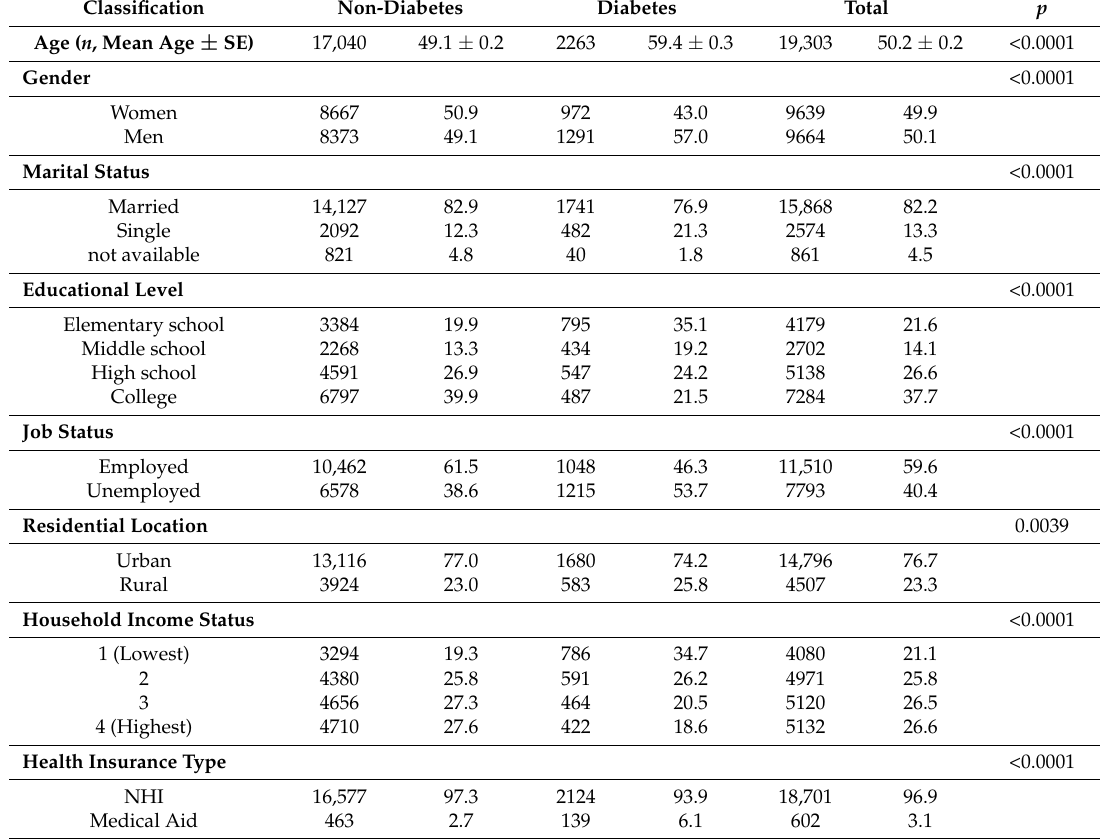
Table 1. Characteristics of the study population with diabetes in the development dataset; a comparison of factors between non-diabetic and diabetic